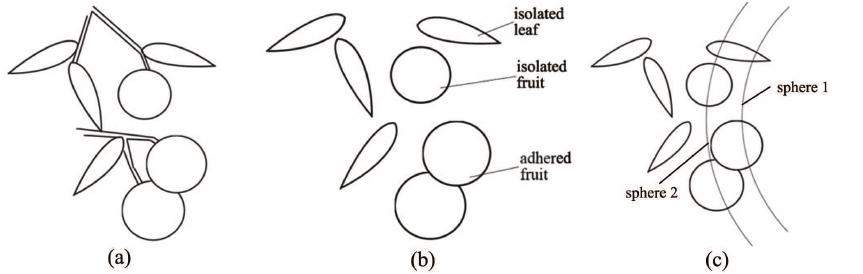
Figure 7. Schematic diagram of the information detection of on-branch citrus: ( a ) canopy; ( b ) clustering; ( c ) multiple depth-sphere